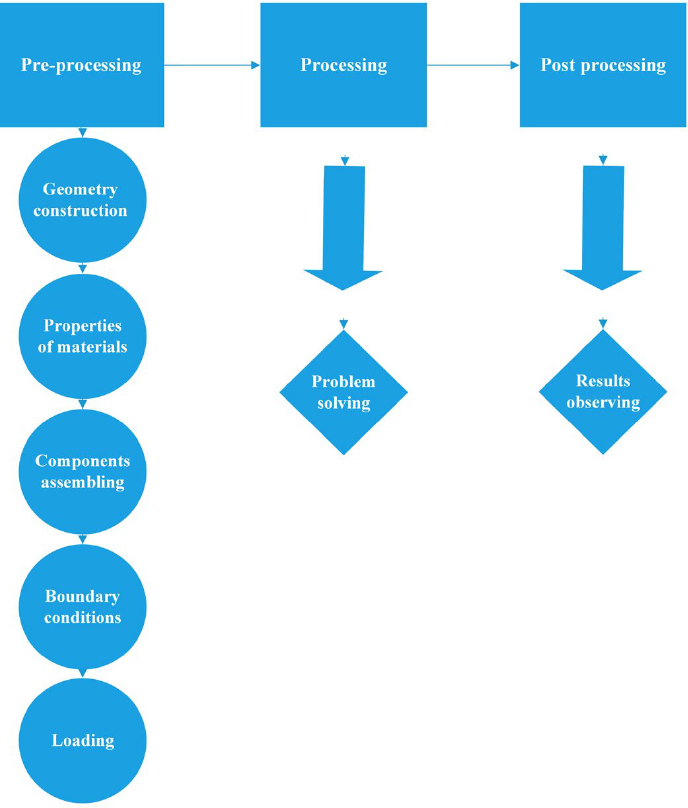
Figure 1. An overview of the three stages by ABAQUS analysis used in the 3D finite-element model in the Azar oilfield.